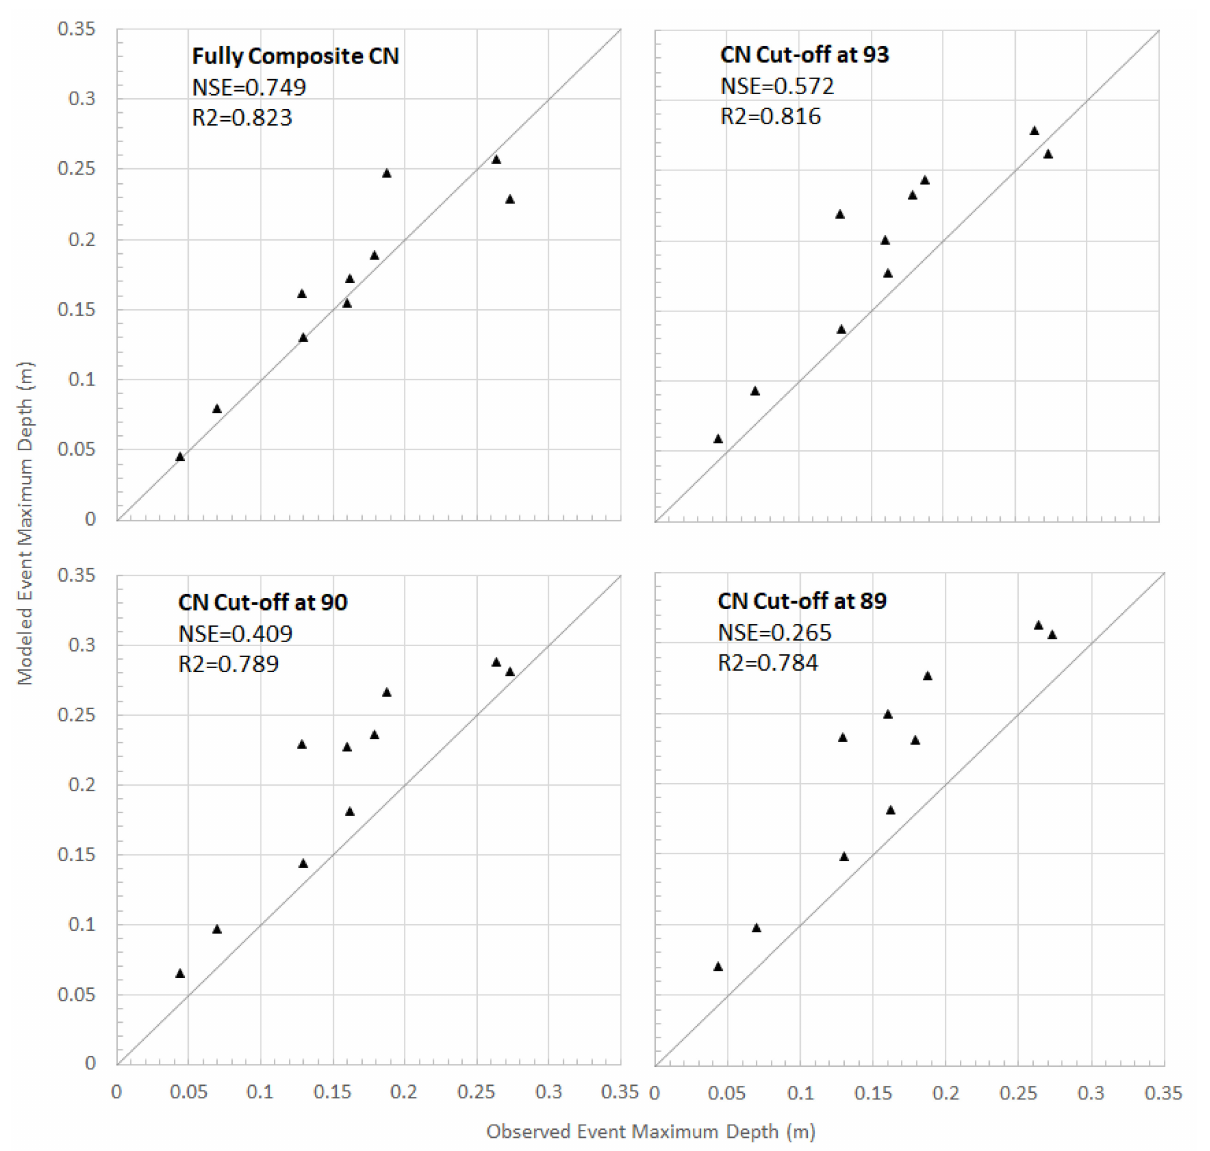
Figure 11. Champions Blvd peak flow depth comparison between observed and modeled